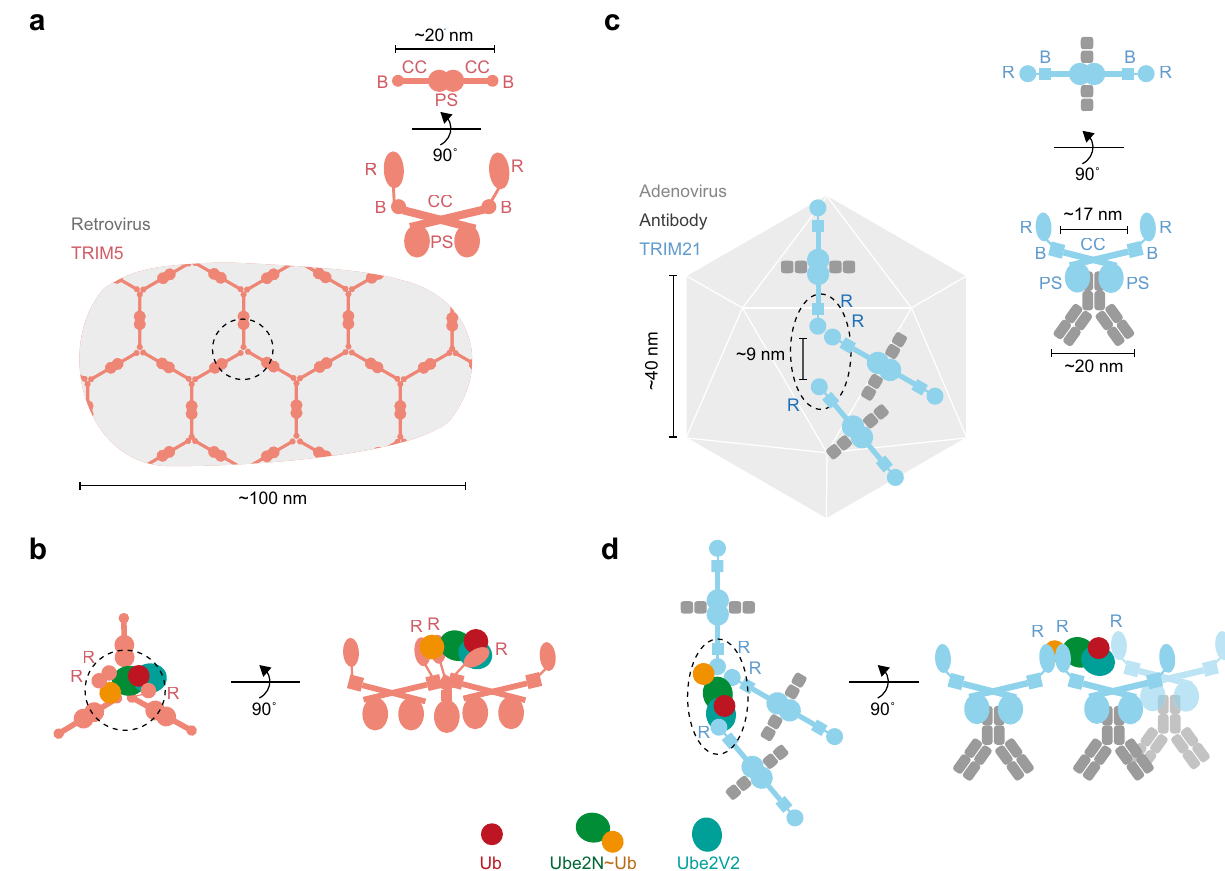
Fig. 6 TRIM protein assembly on viruses. Cartoon models of the assembly of TRIM5 ( a , b ) and TRIM21 ( c , d ) on viral capsids. a Shown is the hexagonal assembly of TRIM5 on HIV-1 capsid as imaged by cryo-electron tomography 48 . c Assembly of TRIM21:antibody complexes on adenovirus capsid (adenoviral measurements are based on 6B1T 68 ). b , d Cartoons visualizing how the TRIM protein assembly on the viral capsid enables the formation of the catalytic RING topology. R RING, B Box, CC coiled-coil, PS PRYSPRY, Ub